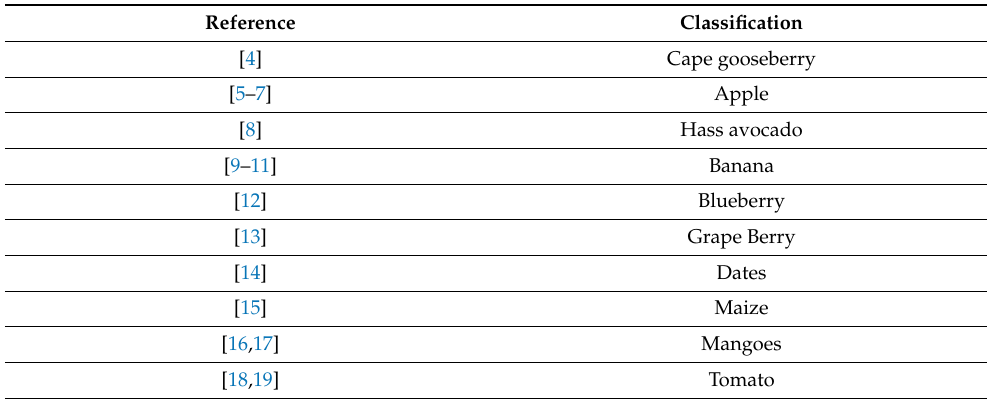
Table 1. Examples of fruit datasets.